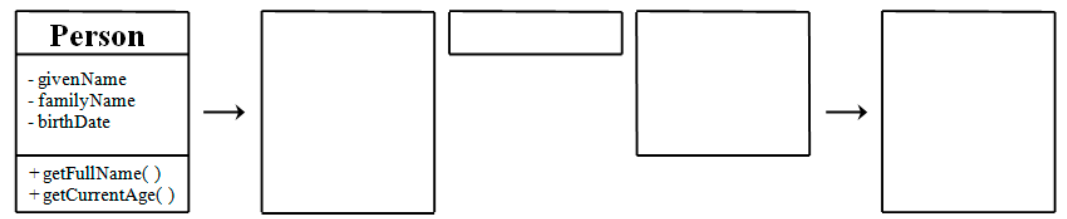
Figure 5. Identification of primary and secondary (contained) rectangles: two secondary rectangles are discarded